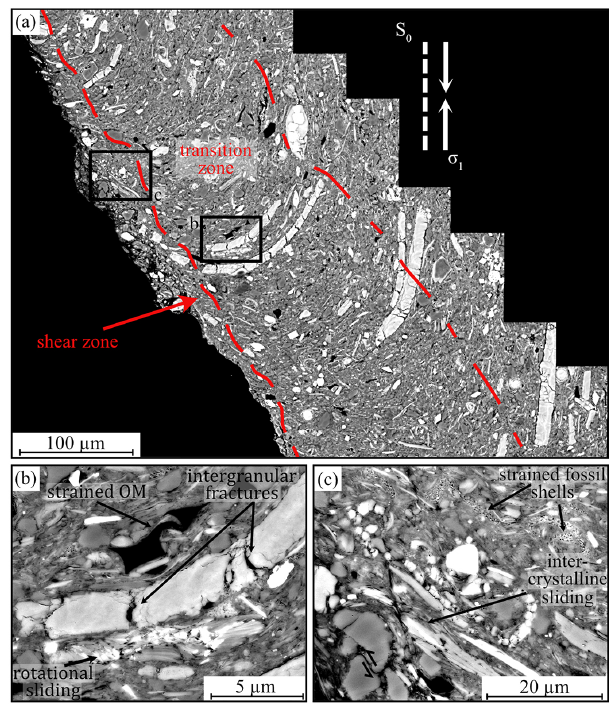
Figure 7. SEM images presenting mesoscopic and microscopic de- formation structures for the samples deformed at 2.5MPa effective consolidation stress. Panel (a) shows a network of multiple, anas- tomosing fractures constituting one of the main shear fractures ob- served on the macro scale. Panel (a’) shows kinking of minerals and disrupted, randomised microfabric in a shear zone. Panel (b) displays a dilatant kink band, which is characterised by a sharply kinked Ca-bearing vein observed in the EDS image (b’) .